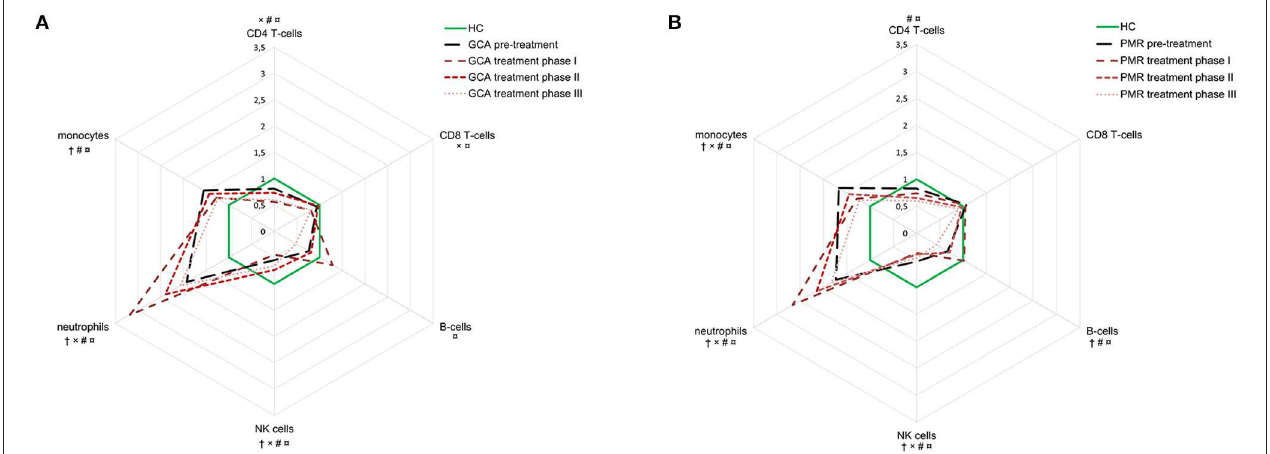
FIGURE 4 | Dynamics in cell population counts during follow-up in GCA (A) and PMR (B) patients. Counts are expressed in radar plots as median fold-change compared to healthy controls ( n = 51) for the following groups: pre-treatment (GCA n = 42, PMR n = 31), treatment phase I (GCA n = 38, 69 measurements; PMR n = 25, 54 measurements), phase II (GCA n = 32, 43 measurements; PMR n = 23, 33 measurements), and phase III (GCA n = 29, 65 measurements; PMR n = 19, 56 measurements). Pre-treatment only includes the visit before start of treatment; treatment phase I includes follow-up visits at 2, 6 weeks, and 3 months; treatment phase II includes 6 and 9 months; treatment phase III includes 12 months and beyond. † : sign difference between HC and baseline, × : sign difference between HC and treatment phase I, #: significant differences between HC and phase II, and ¤ : significant differences between HC and phase III (Mann-Whitney U -test, P < 0.05).